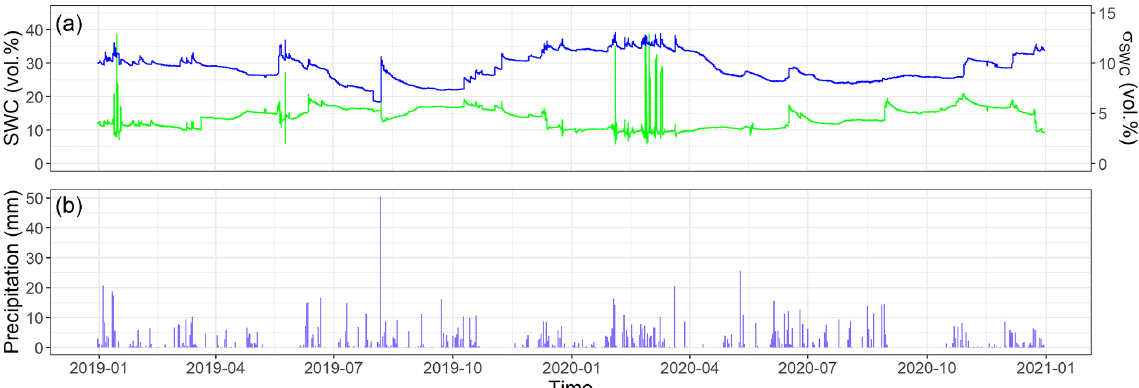
Figure 3. Temporal variations in spatial average soil water content ( a , blue), standard deviation of soil water content ( a , green) from WaTSeN and daily precipitation (b) measured at the northern EC station during 2019–2020. Soil water content is the spatial mean of hourly averaged data from 13 stations of